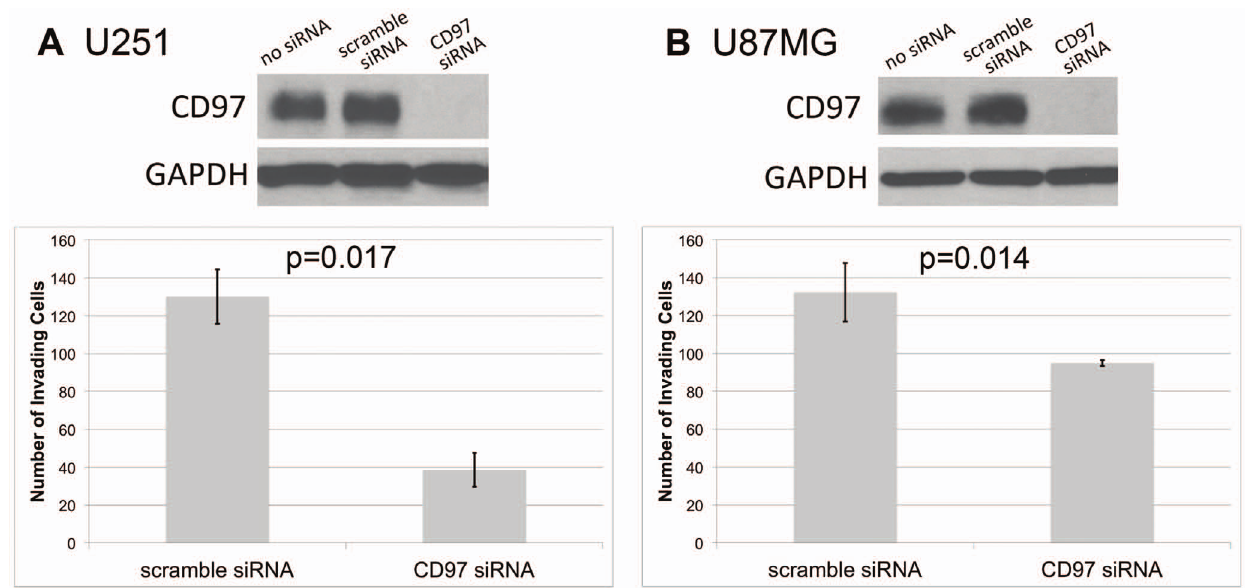
Figure 4. CD97 confers an invasive phenotype. U251 and U87MG cells were subjected to siRNA-mediated knockdown of CD97. In both cell lines, knockdown of CD97 resulted in decreased invasion through a Matrigel invasion chamber. In U251 and U87MG cells, invasion was decreased by 70% (p=0.03) and 28% (p=0.05), respectively (A, B).